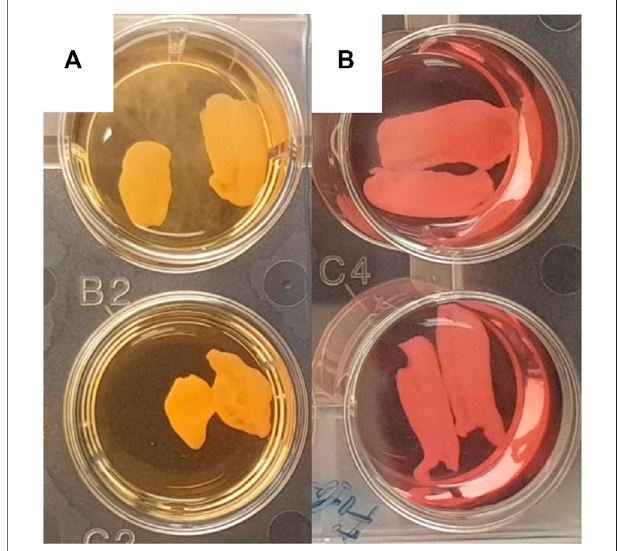
FIGURE 1 | Representative pictures of wells with pig aortic valve lea fl ets instandardmedium (A) andantimyo fi broblasticmedium (B) .Arounded,more ball-like appearance is apparent in lea fl ets in standard